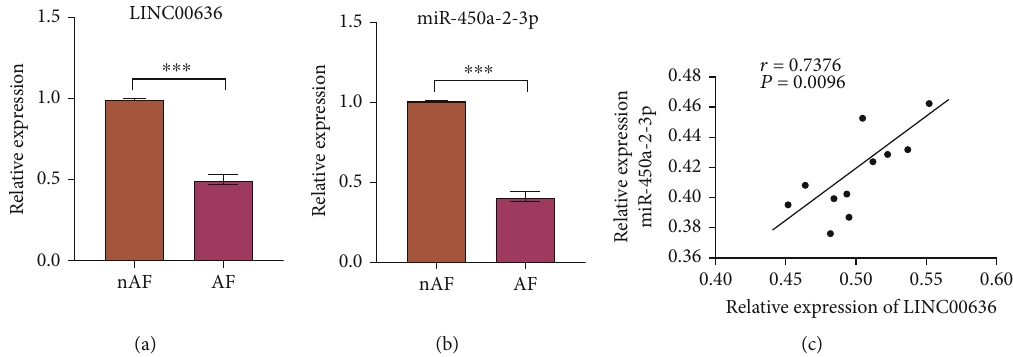
Figure 2: The expression of RNAs in human pericardial exosomes. (a, b) The expression levels of LINC00636 and miR-450a-2-3p determined using RT-qPCR. (c) LINC00636 expression levels are positively correlated with those of miR-450a-2-3p. Data is expressed as mean ± standard deviation calculated from three independent experiments. ∗∗∗ P < 0 : 001